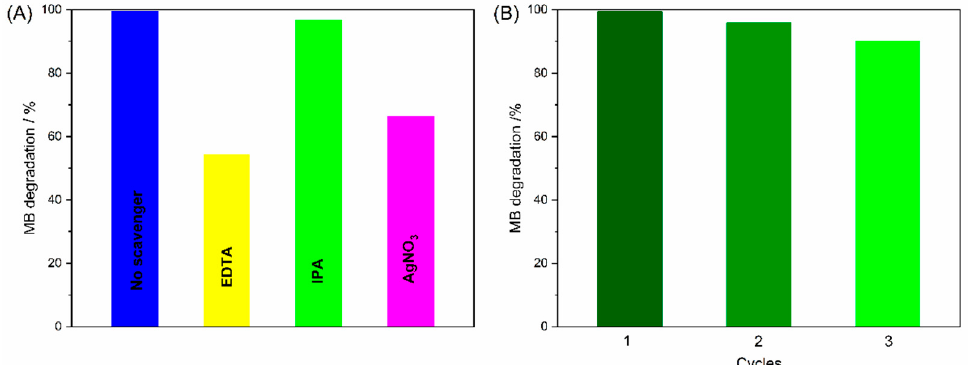
Figure 8. ( A ) Effect of different quenching ( • OH, h + , and e − ) on MB degradation in ultrapure water with scavenger dosage of 0.01 mol L − 1 by using 32% g -C 3 N 4 @TiO 2 under simulated solar light after 90 min of irradiation and ( B ) reusability of prepared 32% g - C 3 N 4 @TiO 2 nanocomposite in three cycles.